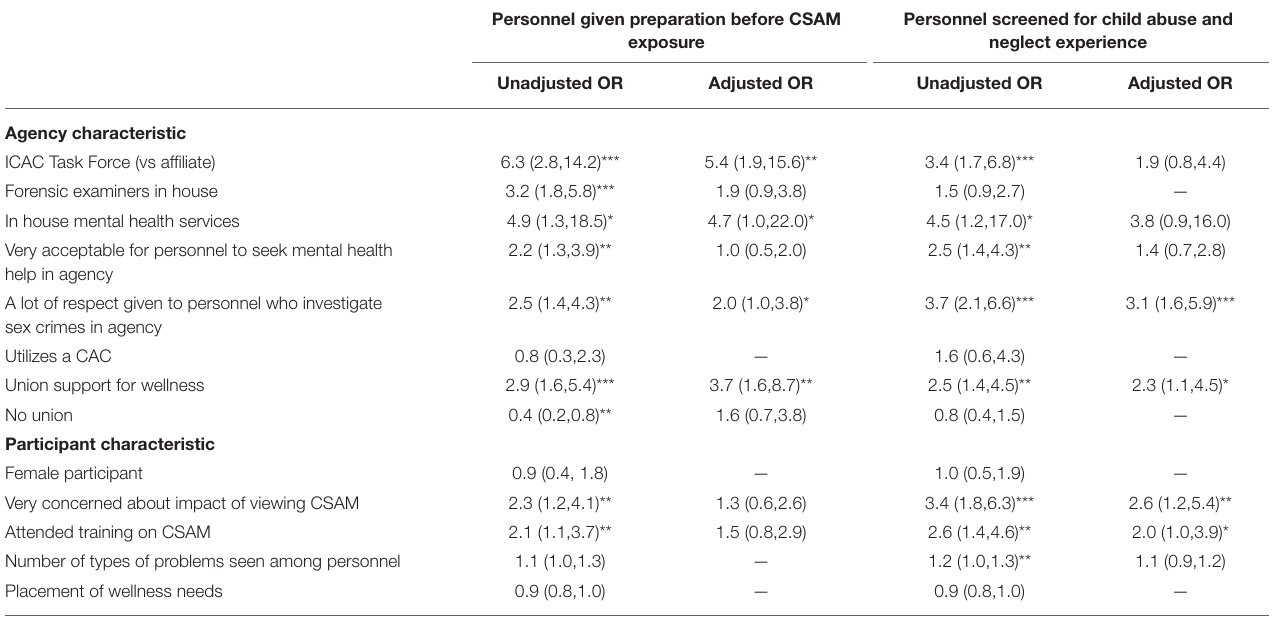
TABLE 4 | Characteristics of agencies engaging in more proactive effort around wellness—policies and practices.